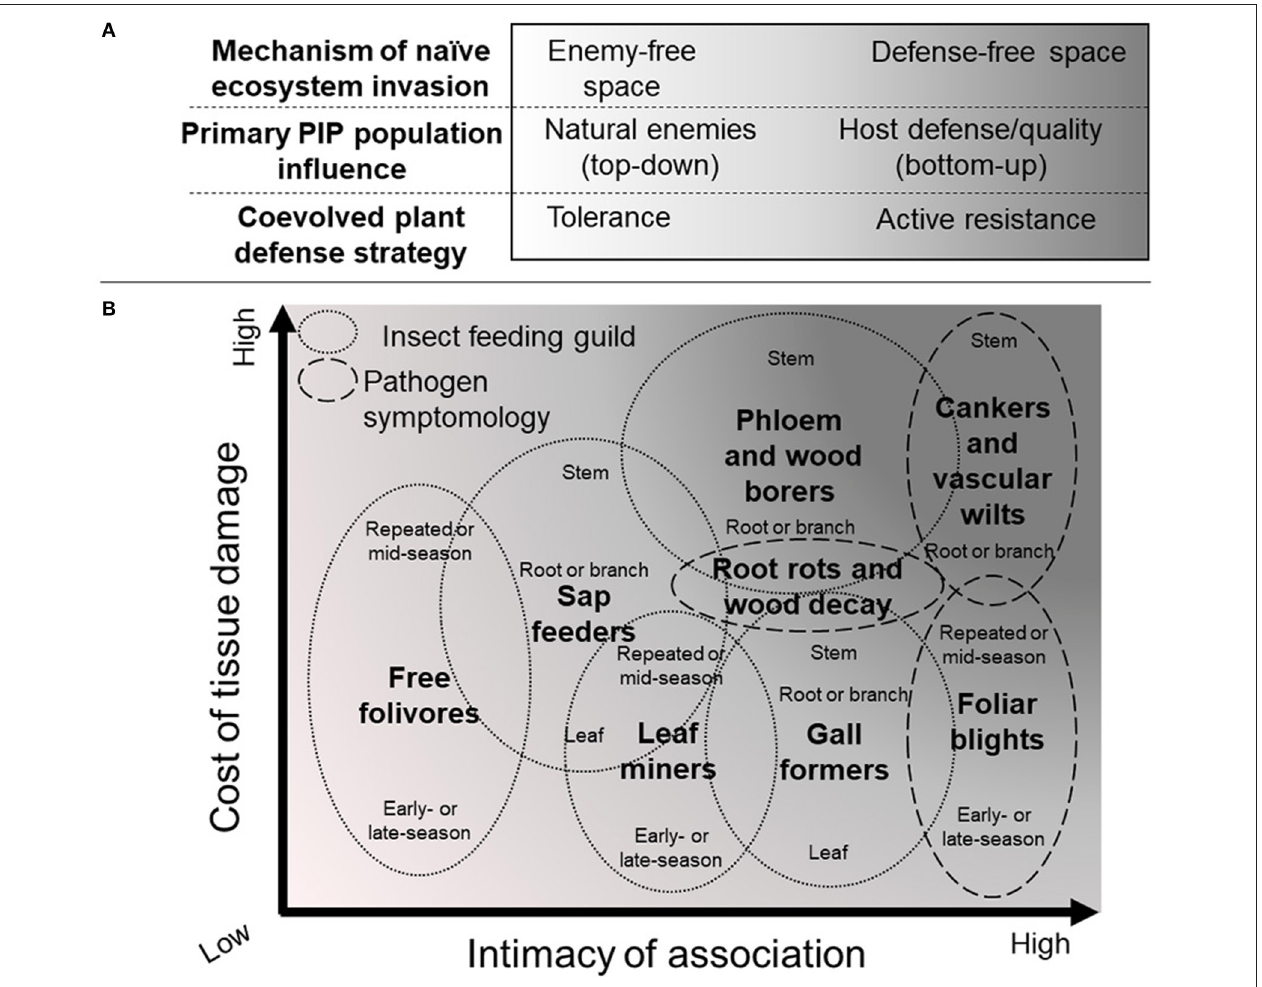
FIGURE 3 | Effective plant defense strategies and associated phytophagous insect and phytopathogen (PIP) traits. (A) Plant defense strategies and corresponding non-native PIP population influences and invasion mechanisms vary along a continuum. (B) Features of the PIP-host interaction, intimacy and damage, are associated with the strategy/influence/mechanism continuum, and with feeding guild, symptomology, phenology, and host tissue. Increasing shading indicates the likely importance of host resistance development in managing invasions of defense-free space. The pests emphasized in this review, i.e., phloem- and wood-borers and cankers and vascular wilts, occupy the darkest shaded, upper right region. Synthesized and adapted from Mattson et al.